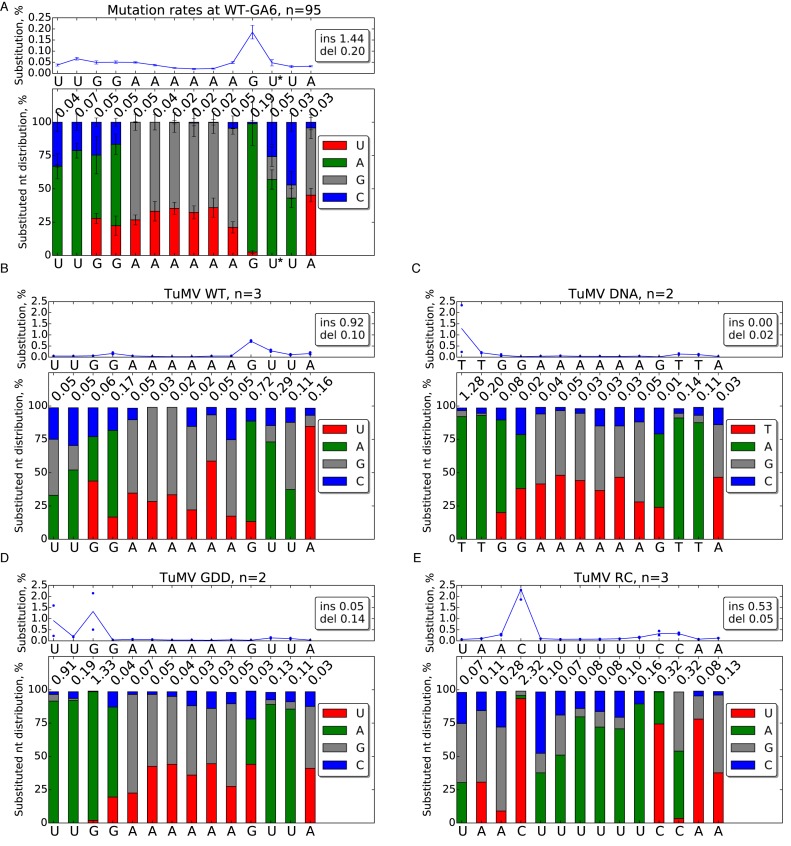
Substitution profiles at WT and mutated slip site sequences. The name and number of samples analysed is presented at the top of each subfigure. The mean frequency (blue line) of detected substitutions at each nucleotide position is shown in the upper graph of each subfigure. Error bars indicate standard deviations; for samples with two or three replicates, blue dots denote individual datapoints. The average rates of single-nucleotide insertions (ins) and deletions (del) occurring at the slip site are shown at right. The lower graph of each subfigure shows the nucleotide distribution of detected substitutions at each position. Mutations to other than the original sequence are indicated as follows: U/T—red, A—green, G—grey, C—blue. For clarity, the average total mutation rate for each position (same value as the blue line in the upper plot) is shown on top of each bar. (A) Mutations occurring at the WT-GA6 site across all tested constructs; n = 95 (at position +8 [asterisk], n = 94 due to the removal of a single deviantly high [by ∼2 orders of magnitude] data point). Note the different y-axis scale in this subfigure. (B) Mutations at the 2nd-GA6 site of construct TuMV WT. (C) Mutations detected using TuMV DNA (plasmid) as source, a control for mutations potentially introduced during library amplification and sequencing. (D) Mutations detected from in planta expressed TuMV RNA, a control for mutations potentially introduced during reverse transcription, library amplification and sequencing. (E) Mutations at the 2nd-GA6 site of construct TuMV RC.